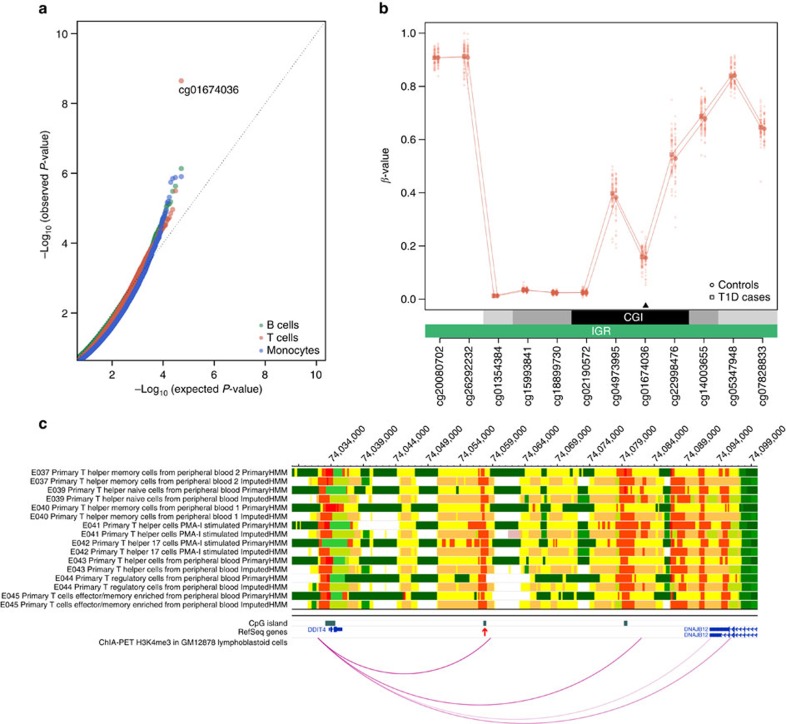
Assessment of the functional significance of the T1D-associated DMP cg01674036.(a) QQ plot for the identification of differentially methylated CpG positions (DMPs) between T1D-discordant MZ twin pairs in different immune effector cell types. Only the DMP cg01674036 reached genome-wide significance in T cells, with P=2.2 × 10−9 (FDR-corrected P=9.1 × 10−4) and a mean DNA methylation difference of 2.3%. (b) Regional plot of the locus harbouring the T-cell-specific DMP cg01674036. The statistically significant DMP is indicated with a black arrow. Data points represent the DNA methylation β-values (y axis) at the indicated CpGs (x axis) in one individual. For each CpG site, we calculated the mean DNA methylation value (indicated with a larger data point). Every CpG site is annotated with regards to epigenomic feature and gene element using the 450K array annotation manifest. (c) Annotation of the genomic locus using epigenomic reference data sets. The genomic locus on chromosome 10q22.1 (position=74,028,000–74,100,000; genome build=hg19) harbouring the DMP cg01674036 (chr10:74,058,002) is shown using the WashU Epigenome Browser v40.0.0 (http://epigenomegateway.wustl.edu/browser/). The T1D-associated DMP is located at a CpG island (indicated with a red arrow). A total of 16 epigenomic reference tracks provided by the Roadmap Epigenomics project are displayed. Specifically, we show both the primary and imputed chromatin state maps in eight distinct primary T cell populations. The highlighted CpG island overlaps with an active transcription start site (red) or enhancer (orange/yellow) in all available T cell populations. In addition, H3K4me3 ChIA-PET data in the lymphoblastoid cell line GM12878 revealed a long-range chromatin interaction between the active regulatory element and the gene promoter region of DDIT4. CGI, CpG island; ChIA-PET, chromatin interaction analysis by paired-end tag sequencing; IGR, intergenic region.